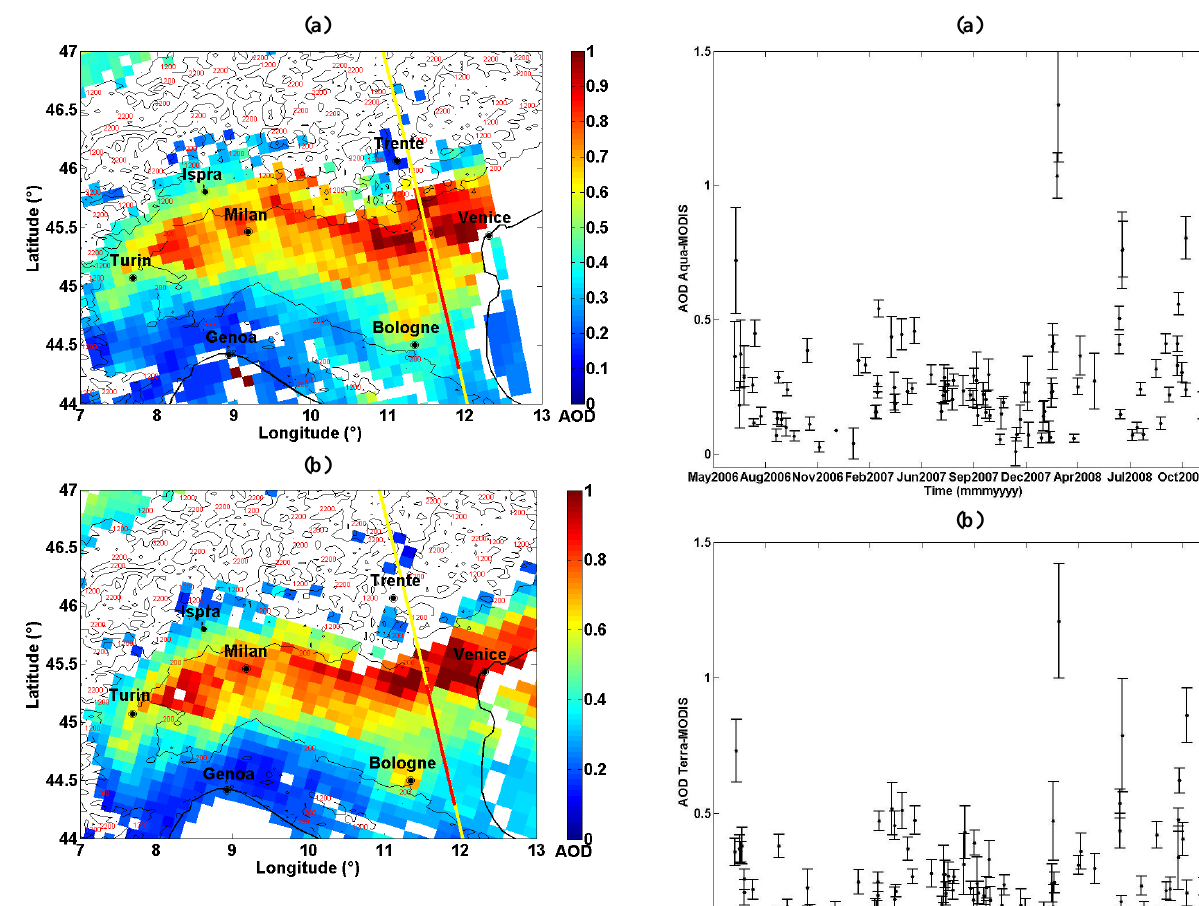
Fig. 2: AOD map at 550 nm over the Po Valley on the 16 March 2007 from (a) MODIS-Aqua at 12:20 UTC and (b) MODIS-Terra at 10:40 UTC. The topography levels around the Po valley are shown in black lines. The yellow solid line represents the ground-track of CALIPSO orbits that have been considered and the red section highlights the useful part of the orbits with an altitude lower than 0.2 km AMSL.